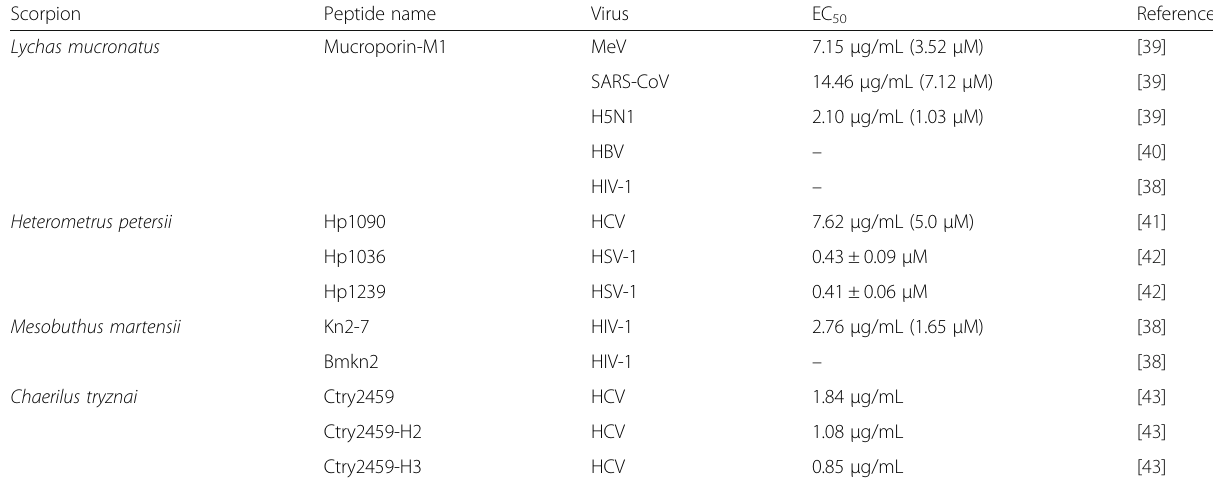
Table 1 Scorpion peptides and derivatives with antiviral